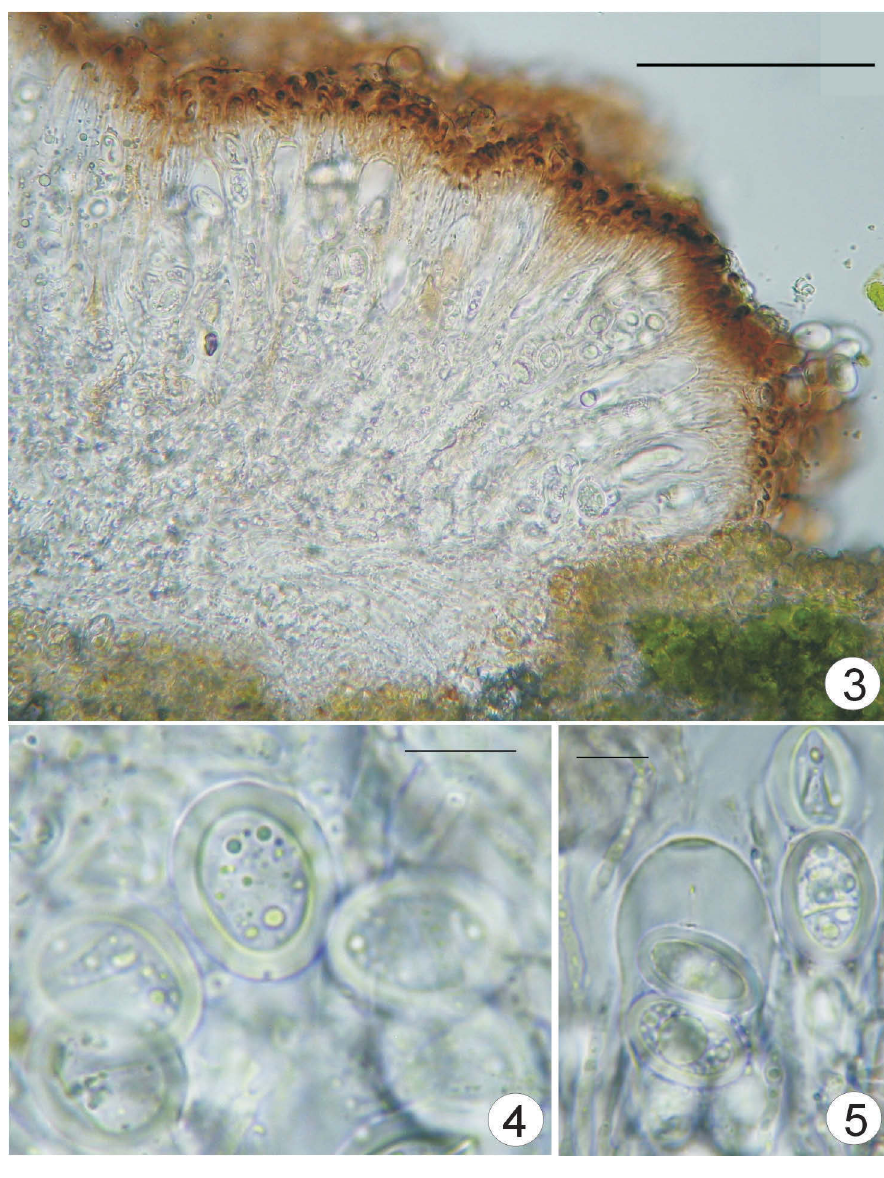
Figs 3-5 . Japewia tornoensis ( Czarnota , GPN 5637): 3. Apothecial section. Scale bar = 100 μm, 4-5. Ascospores with strongly thickened walls. Scale bars = 10